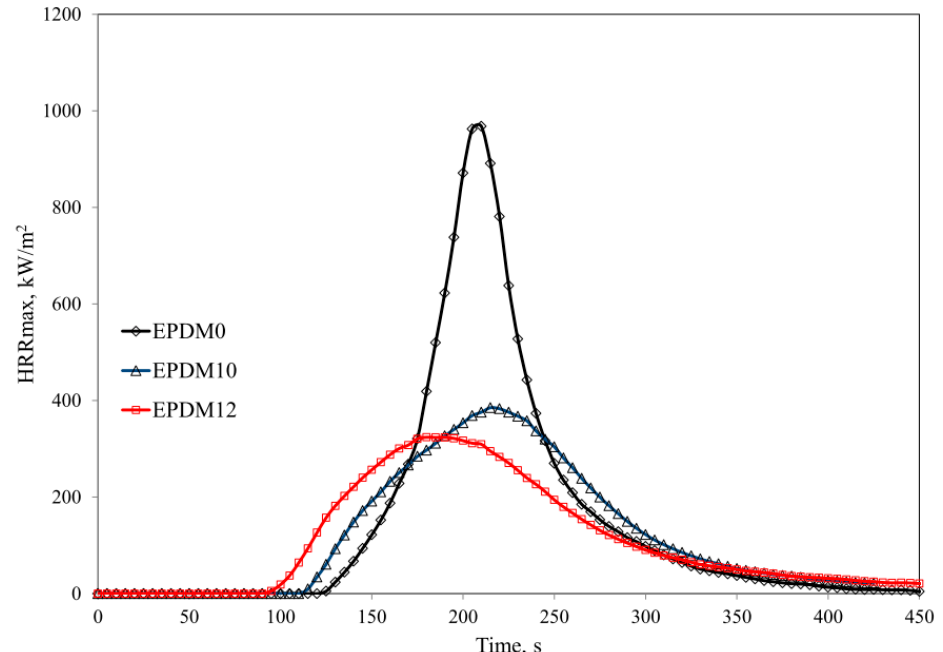
Figure 5. HRR curves of the EPDM-filled composites.